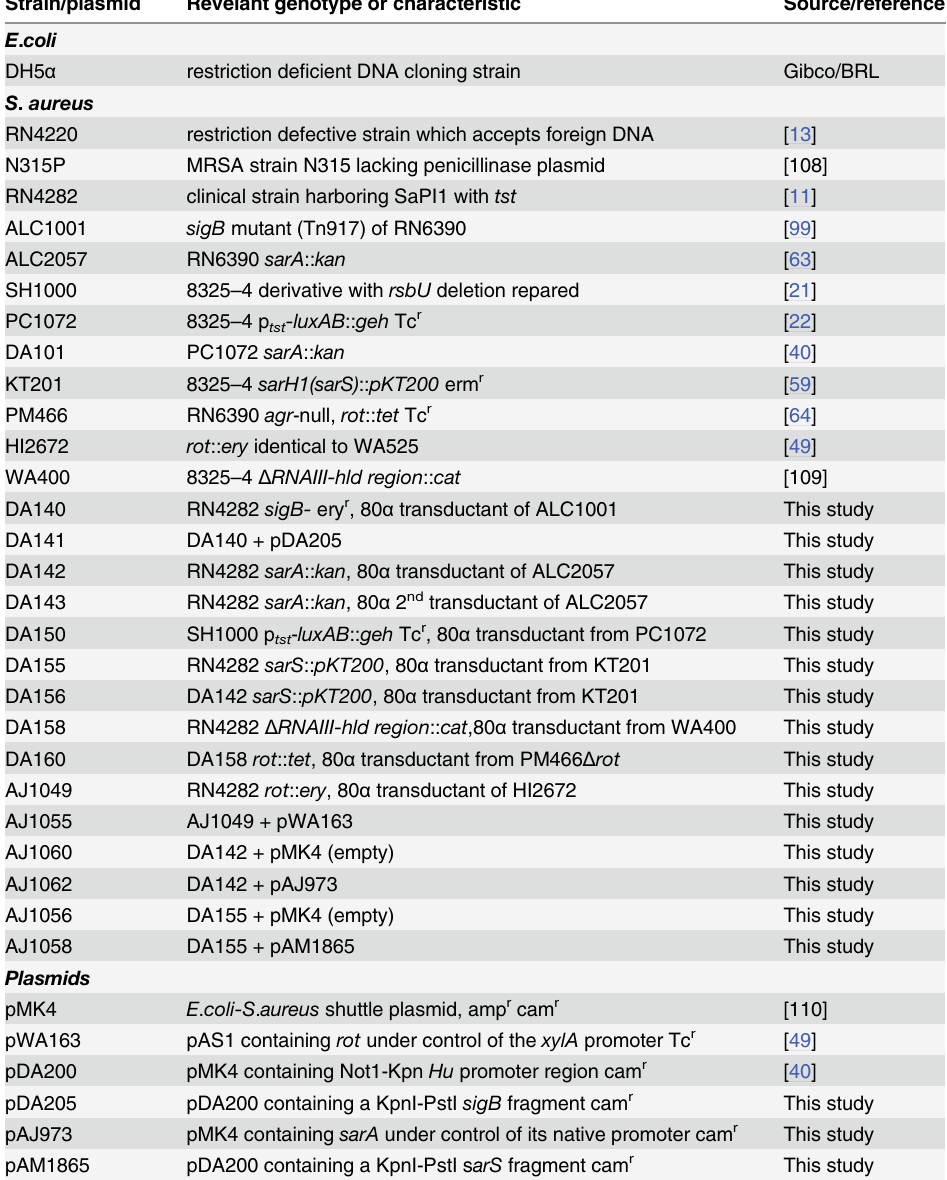
Table 1. Bacterial strains and plasmids used in this study.